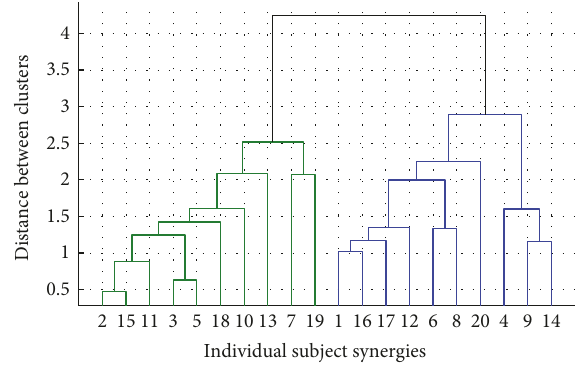
Figure 12: Synergy clusters using hierarchical clustering. Natural data divisions are found when the height of a link strongly di ff ers to the height of the links below it. Thus, in this case, the clusters are well